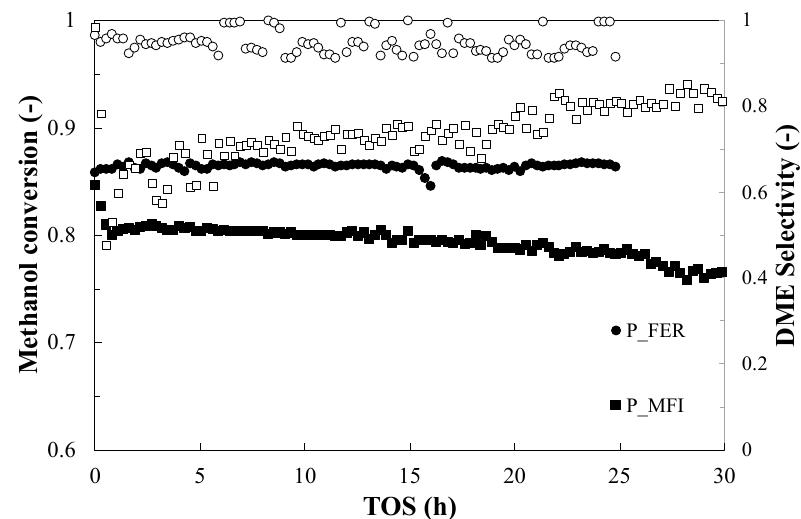
Figure 4. Methanol conversion (closed symbols) and DME selectivity (open symbols) during TOS for the parent samples. Test conditions: T = 260 °C; Methanol = 5.6%; Carrier flow rate (N 2 ) = 60 NmL/min; WHSV = 2.3 h − 1 .